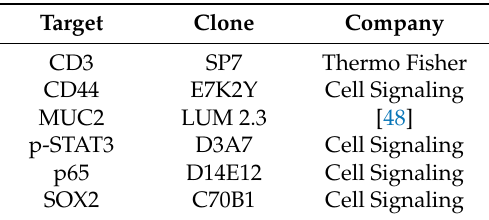
Table 2. Antibodies used in this study.